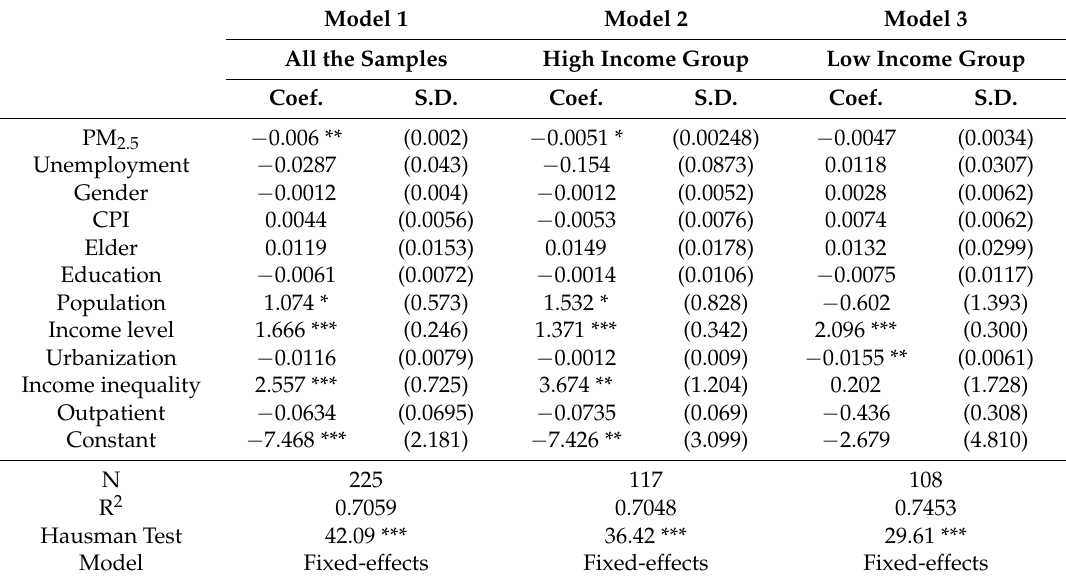
Figure 3. The level of Happiness and Inequality of Happiness in the Chinese Provinces. Table 2. Impacts of PM 2.5 concentrations on the level of happiness and their heterogenous effects.